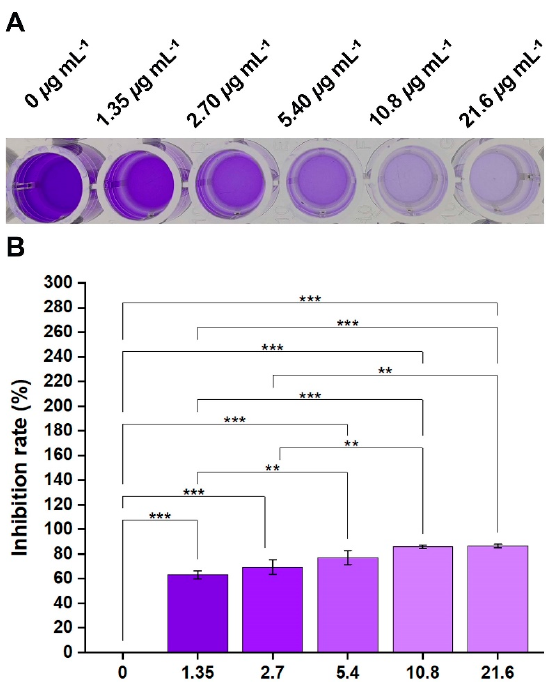
Figure 4. The quantitative assessment of crystal violet revealed the Xanthomonas oryzae pv. oryzae - biofilm inhibition of compound 2b . ( A ) Biofilm staining imagins. ( B ) Inhibition rate of biofilm formation. [(**) p < 0.01, (***) p < 0.001 vs. 0].